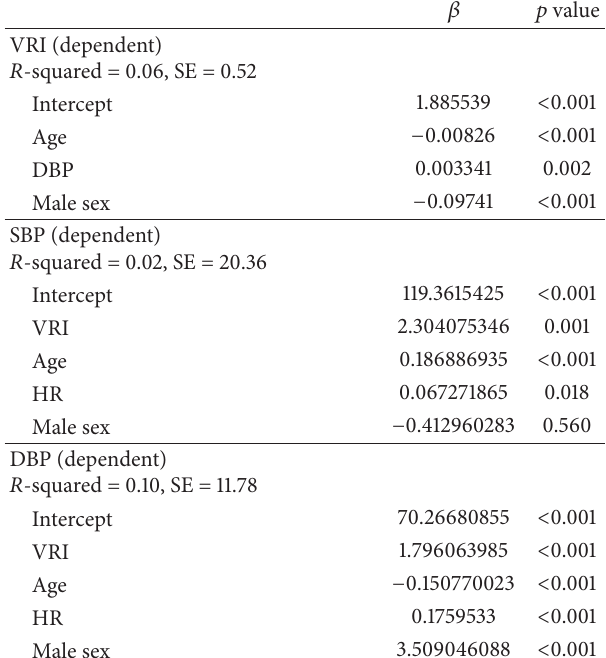
Table 2: Multiple linear regression models for VRI, SBP, and